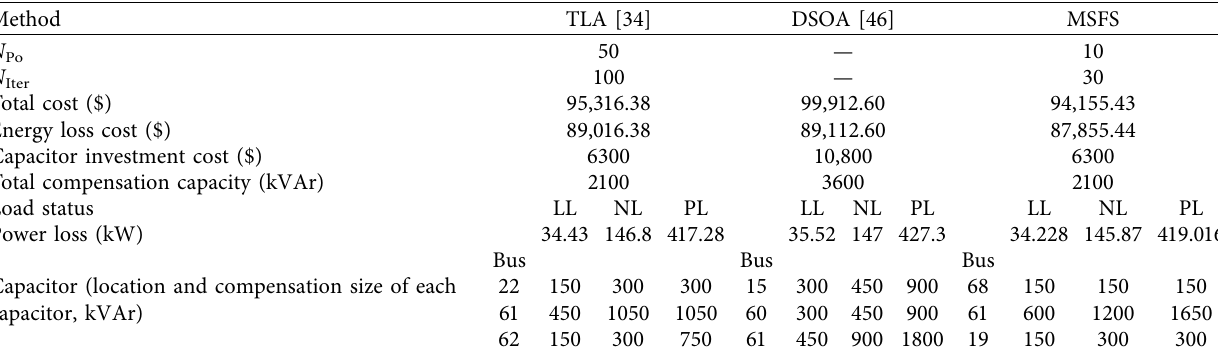
Table 12: Comparisons of result obtained by MSFS and other methods for the 69-bus system with the objective function of total cost.